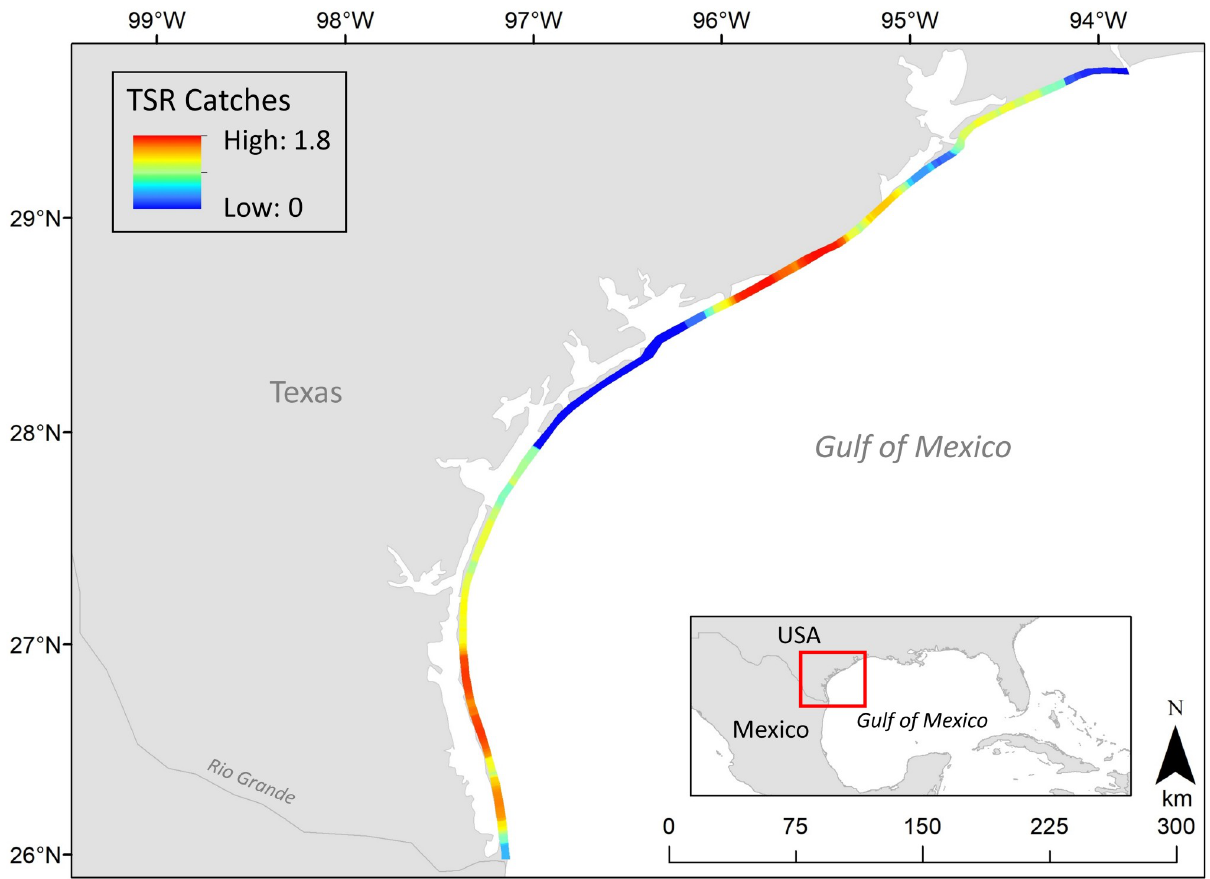
Fig 1. Map of Texas coastline showing hotpots of land-based sharks catches during the Texas Shark Rodeo, 2014–2018. Shark catches are depicted using point density (number of sharks/km 2 ) over a grid of 50 x 50 m cells. Base-maps are used freely from Natural Earth (naturalearthdata.com).